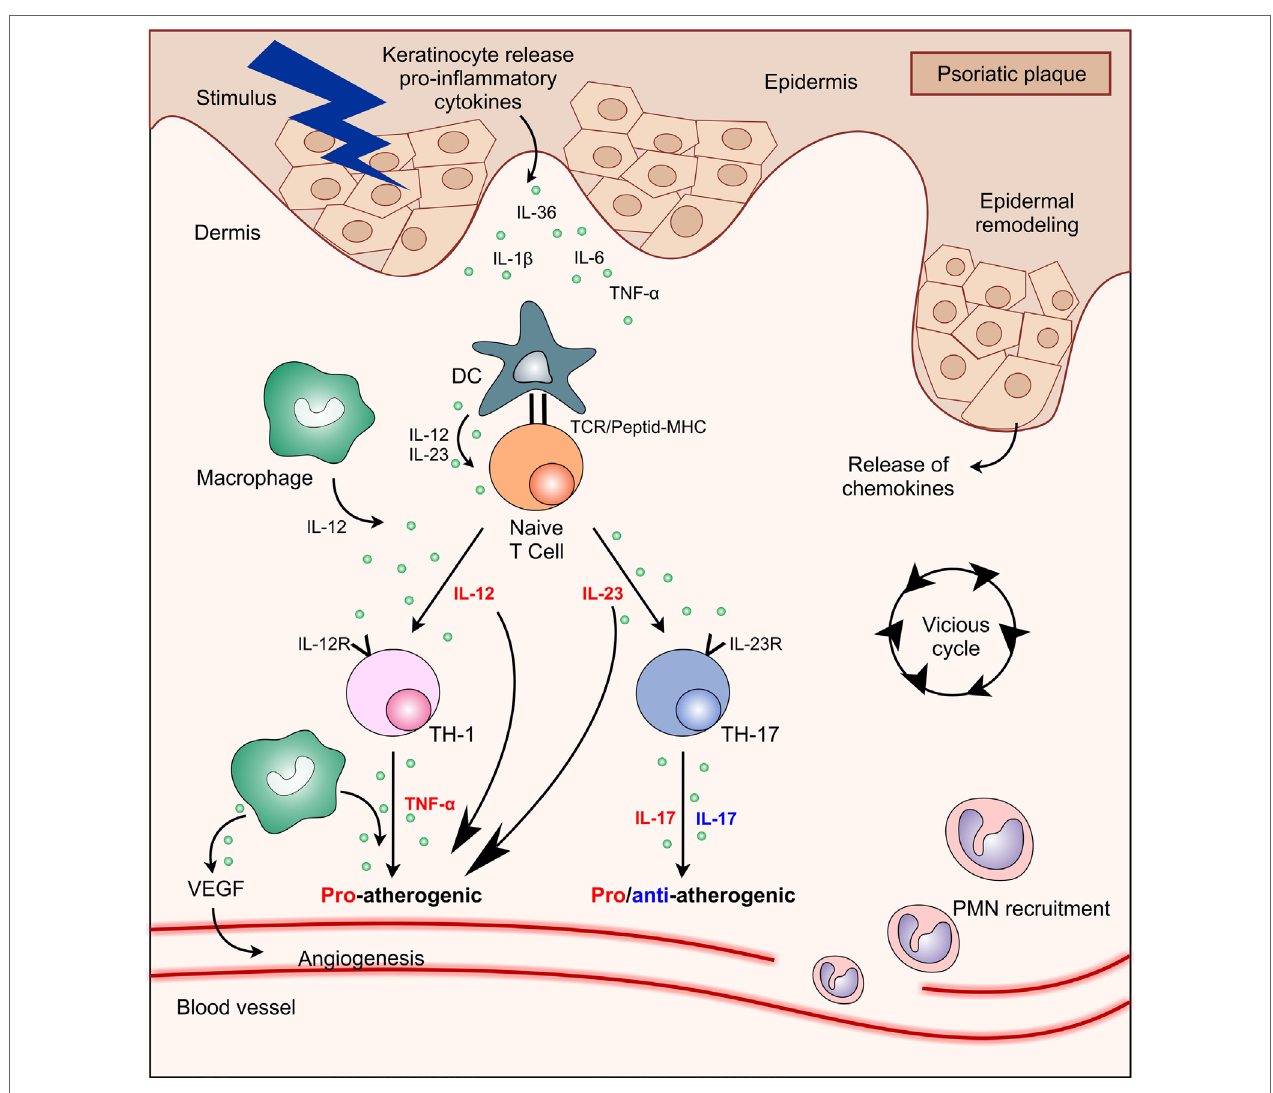
FigURe 1 | Interactions between main cell types and cytokines present in psoriasis plaque showing their functional significance in atherosclerosis process. Abbreviations: DC, dendritic cell; IL, interleukin; MHC, major histocompatibility complex; PMN, polymorphonuclear; TCR, T cell receptor; Th, T helper; TNF, tumor necrosis factor; VEGF, vascular endothelial growth